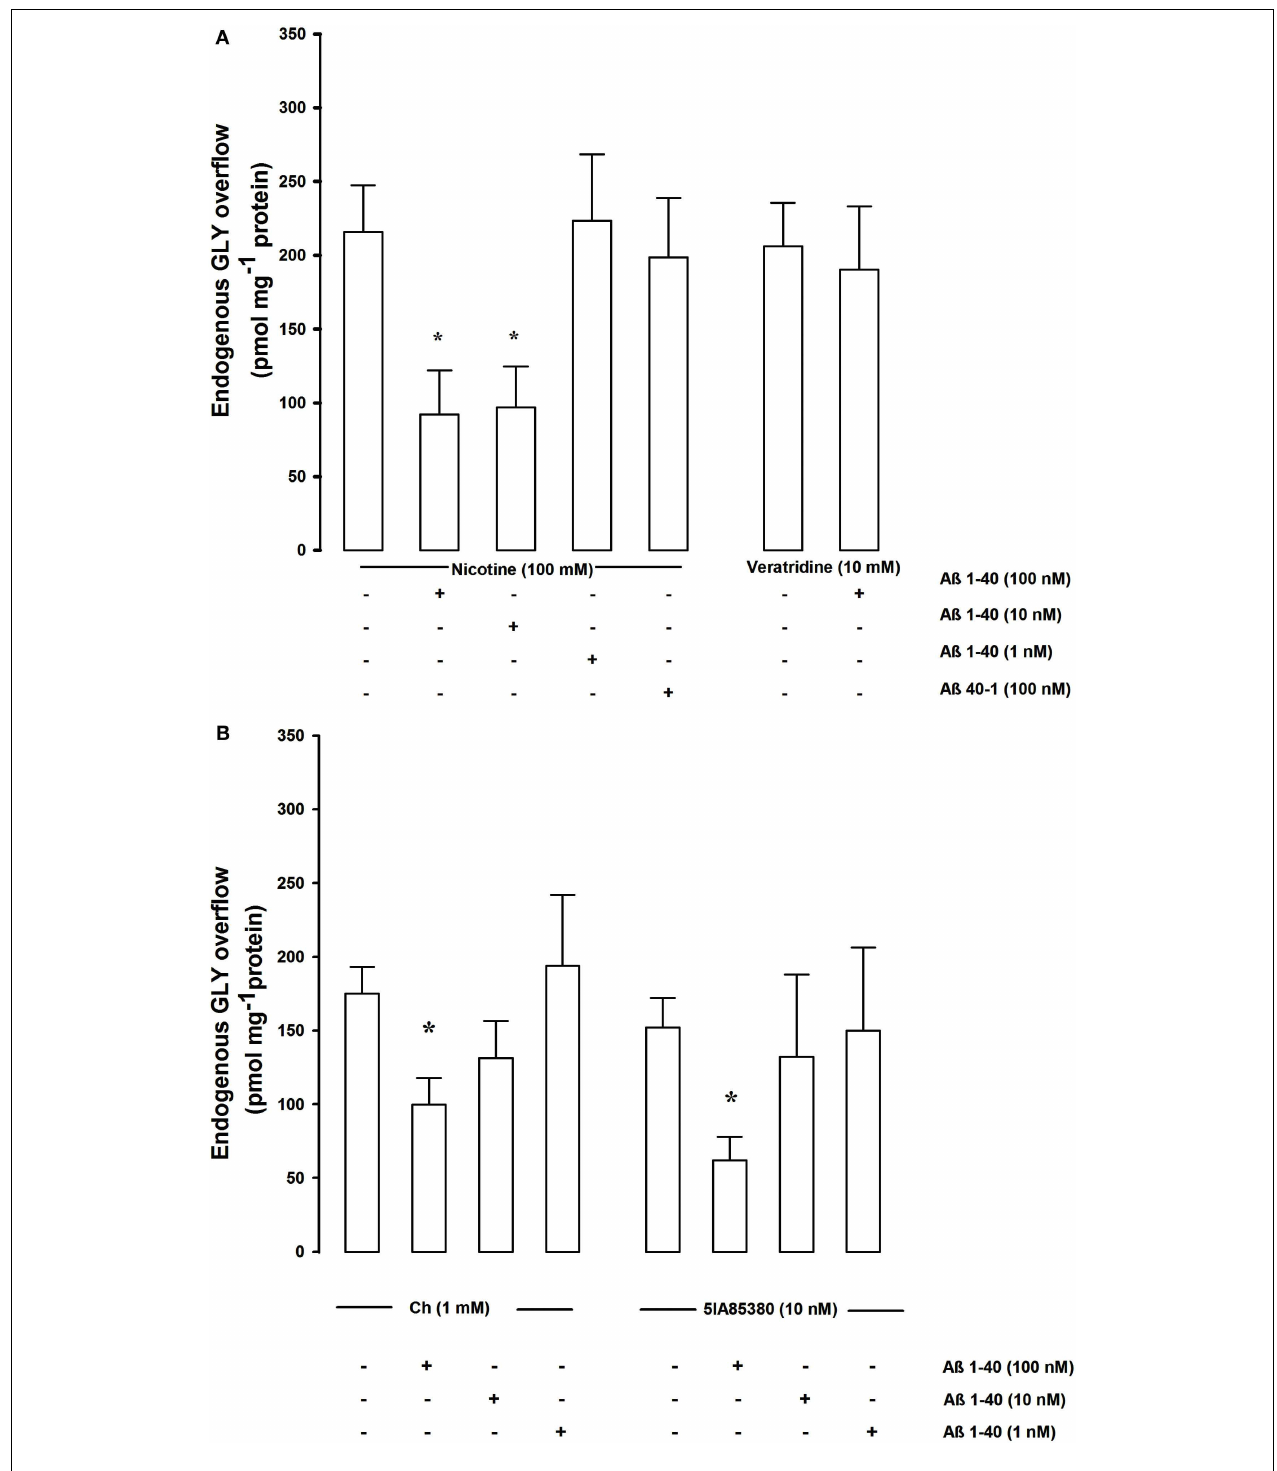
post hoc Test). (B) Shows the concentration dependence effects of A β on Ch and 5IA85380 evoked endogenous GLY overflows from rat hippocampal synaptosomes. Data are mean ± SEM of three to six experiments for each concentration run in triplicate. * p < 0.05 versus Ch-evoked GLY overflow (one-way ANOVA followed by Dunnett’s Multiple